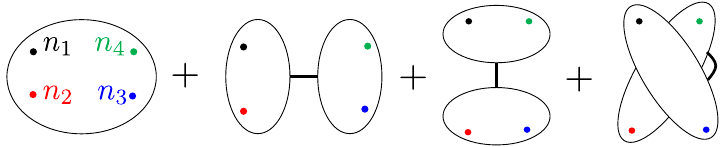
Figure 11. The diagrammatic rule to compute the four-point function after the Gram-Schmidt or- thogonalization. As in the standard rule for computing the correlators in the double-trace-deformed AdS/CFT, we correct correlators only when the deformed operator is exchanged in the diagram. For the four-point function, there are three possibilities (s-, t-, and u-channels) and we need to subtract them to compute the correct four-point function. Here again the thick black lines denote the